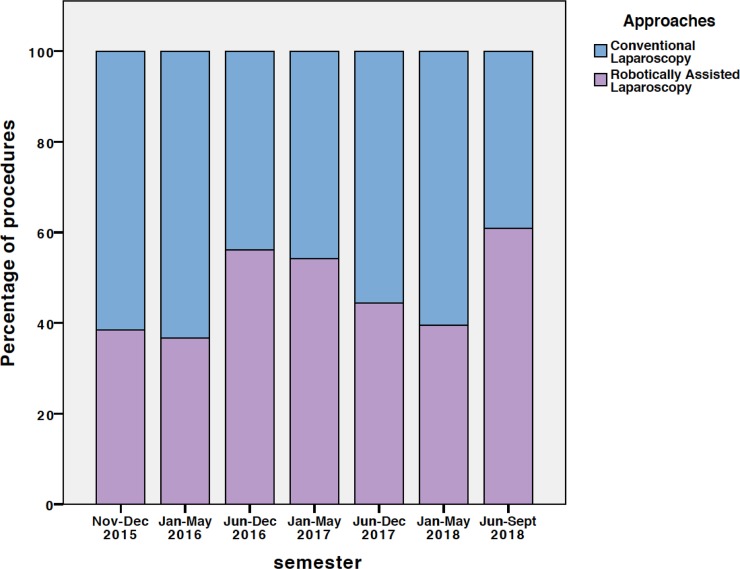
Percentage of minimally invasive procedures performed by conventional laparoscopy and robotically assisted laparoscopy over time.